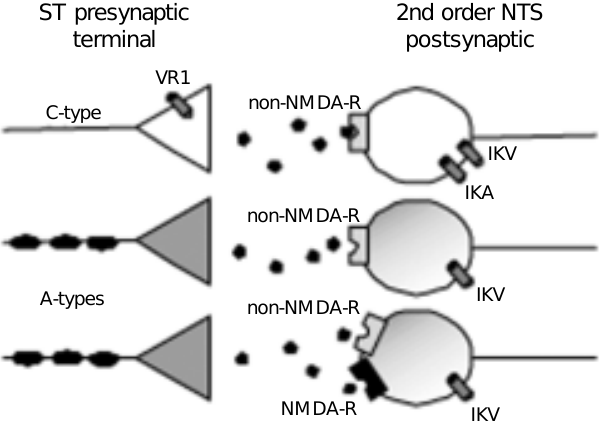
Figure 2. Solitary tract (ST) afferents fall into two broad classes based on the presence of the vanilloid receptor (VR1). Capsaicin-sensitive afferent axons are considered to be unmyelinated, C-type. A-type, myelinated ST axons as well as postsynaptic neurons are devoid of VR1. The anesthetic ketamine blocks NMDA receptors of a subset of A-type ST innervated neurons. Thus, presynaptic A- and C-type ST afferent terminals are highly differentiated on the basis of ligand- and voltage-dependent ion channel expression. Differential expression of pre- and postsynaptic effector proteins is likely to extend to particular ion channels as well as receptors (ionotropic and metabotropic). This offers multiple sites of potential action even for a single transmitter. These differences may provide the mechanistic basis for differential processing unique to each pathway. IKA = A-type potassium current; IKV = voltage-dependent potassium current; NMDA-R = N-methyl-D- aspartic acid postsynaptic receptors; NTS = nucleus tractus